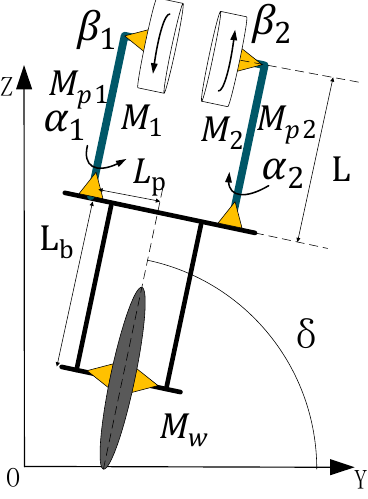
Figure 1. Lateral model of the unicycle robot.